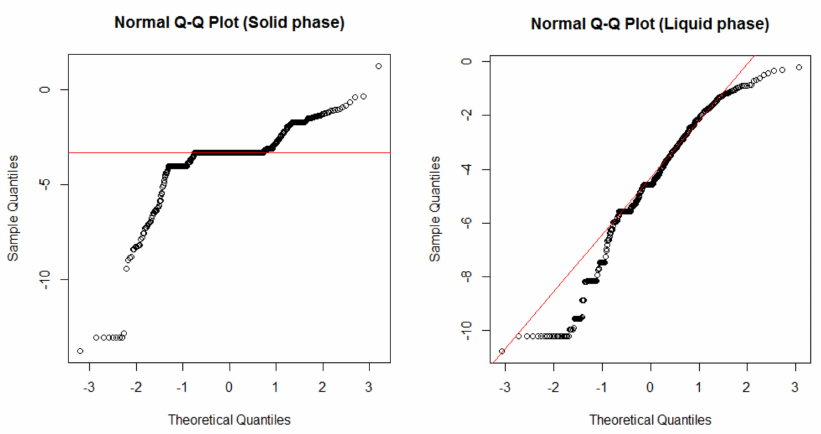
Figure 5. Normal Q–Q plot of exposure data for each